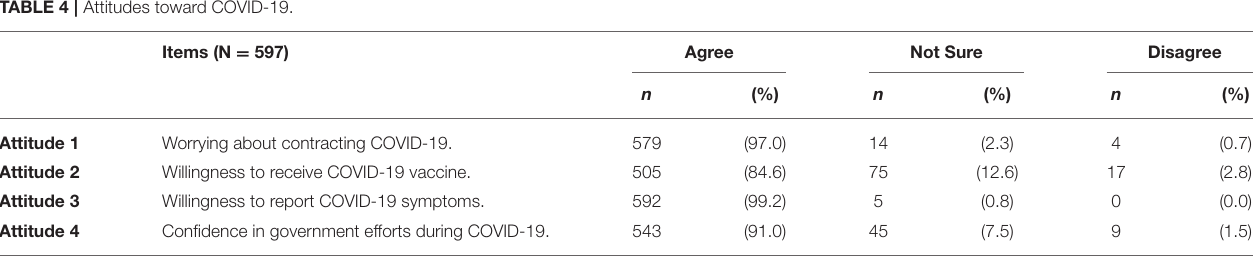
TABLE 4 | Attitudes toward COVID-19.